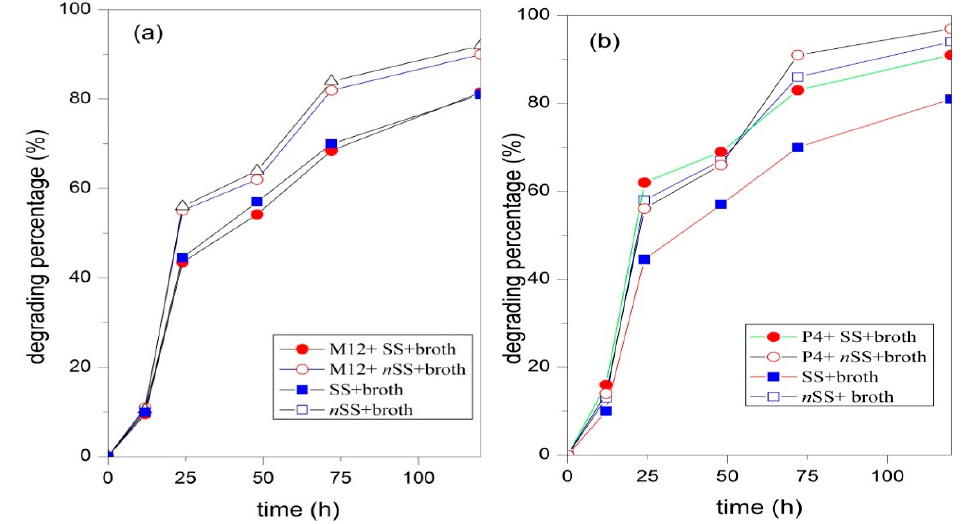
Figure 3. The degradation of UDMH in soil: ( a ) the degradation in sterile soil (SS) and non ‐ sterile soil ( n SS) with the M12 strain; ( b ) the degradation in SS and n SS with the P4 strain. ( n SS) with the M12 strain; ( b ) the degradation in SS and n SS with the P4